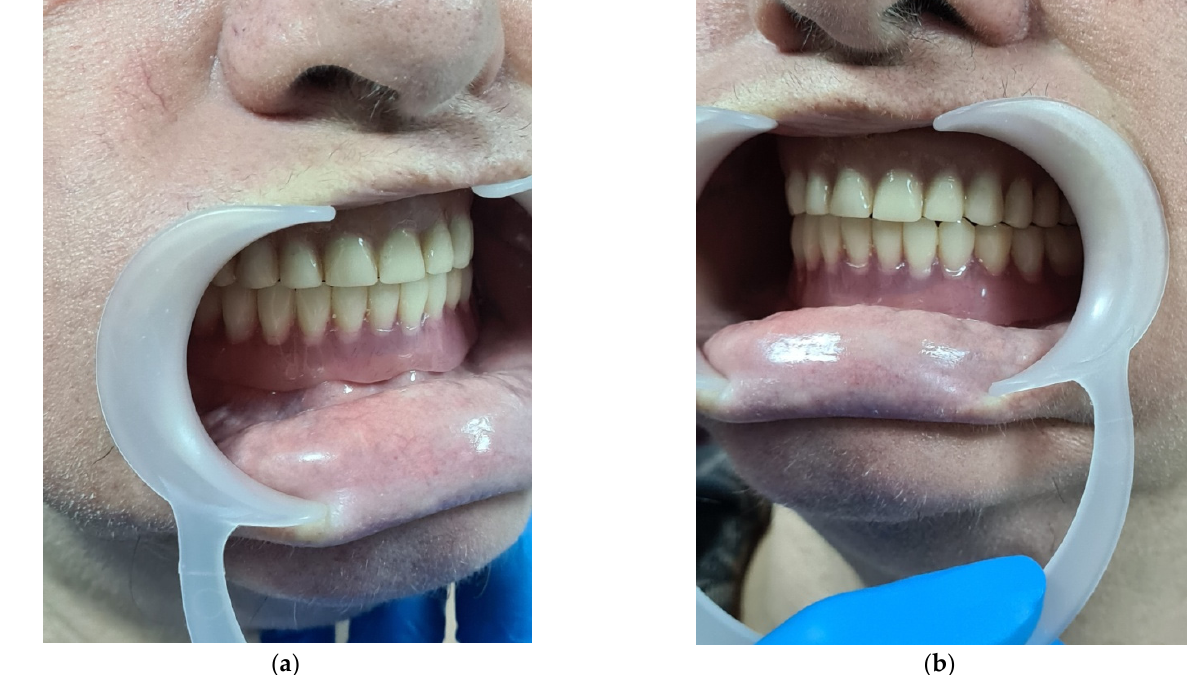
Figure 16. Intra-oral final denture ( a ) left view; ( b ) right view.